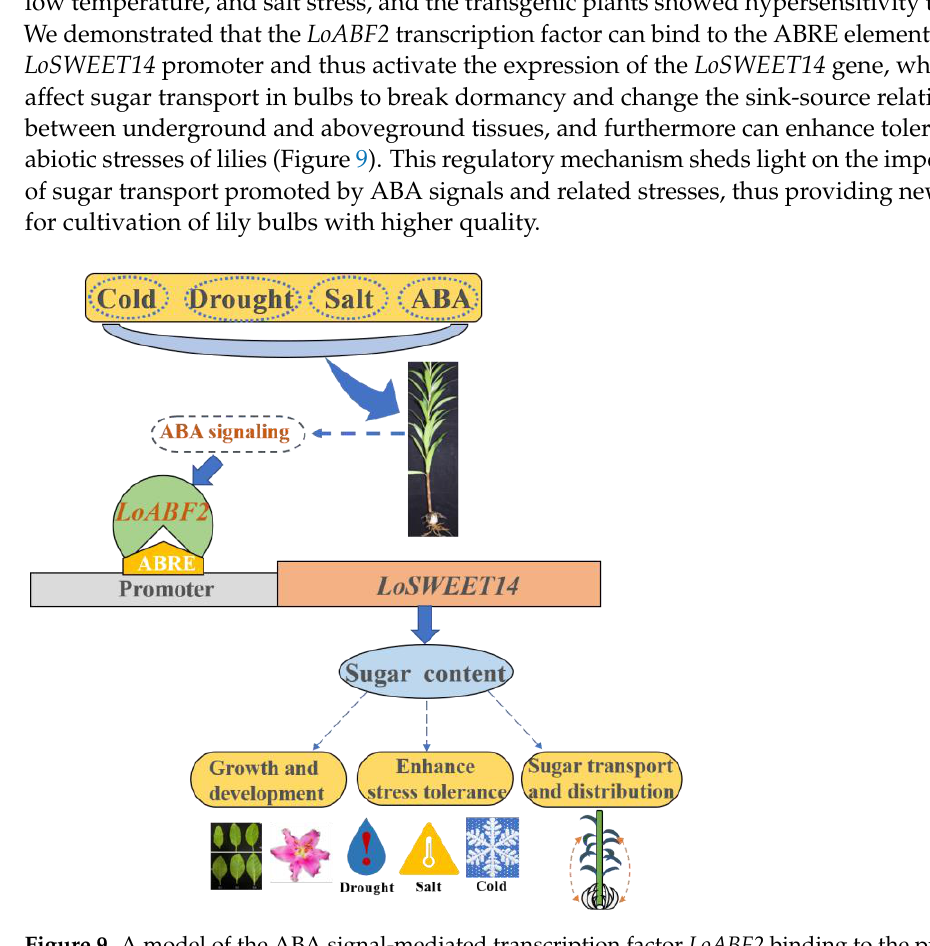
Figure 9. A model of the ABA signal-mediated transcription factor LoABF2 binding to the promoter of LoSWEET14 to induce sugar accumulation under abiotic stress.